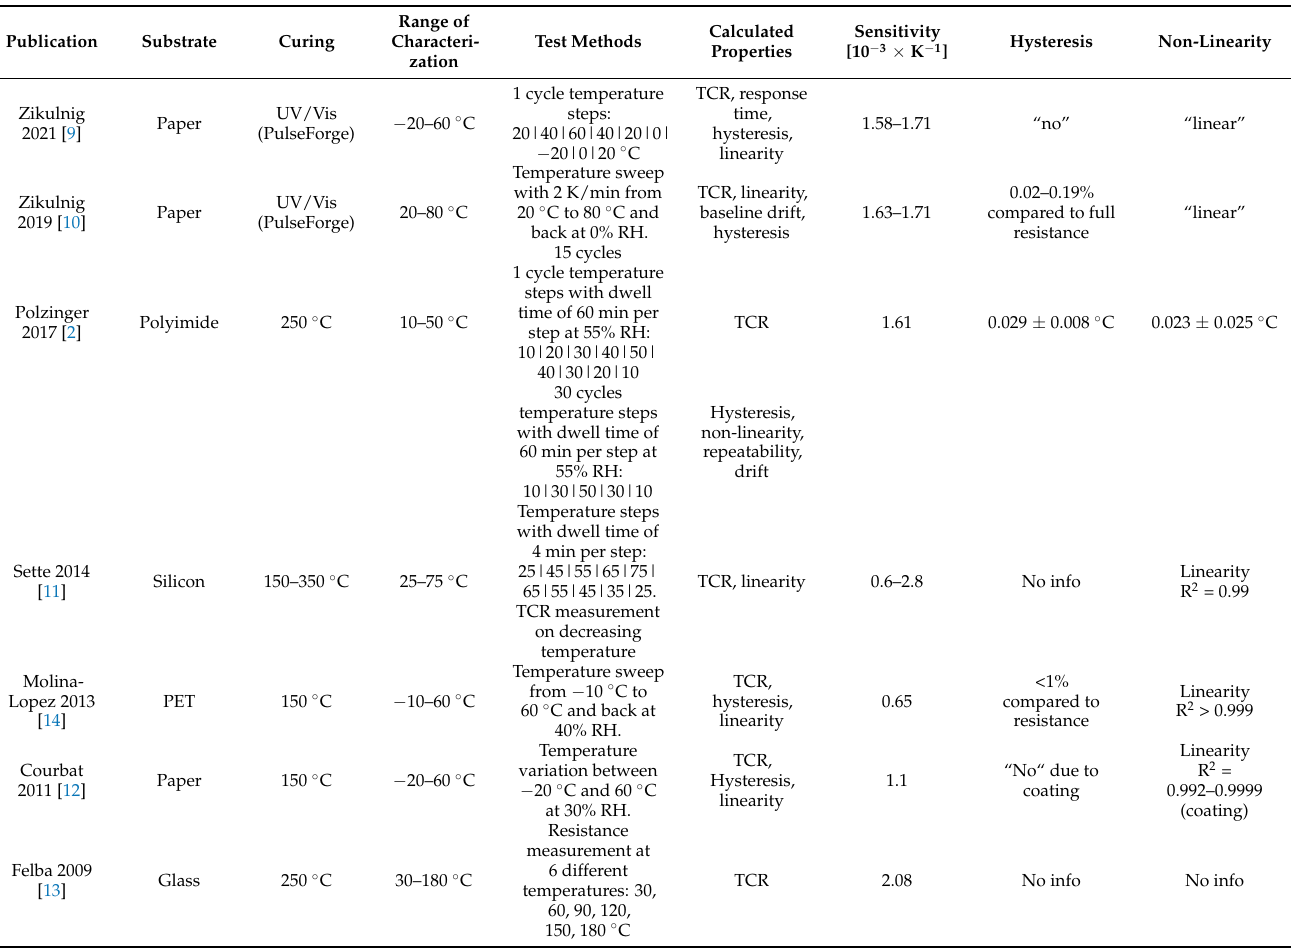
Table 1. Along with the TCR, the substrate, sintering method, range of characterization, test methods, as well as the hysteresis and non-linearity of inkjet-printed silver nanoparticle temperature sensors, are listed in Table 1. The ideal sensor should have a low hysteresis and a linear behavior. The values for these properties vary between different publications and are often stated with “no hysteresis” or “linear behavior”. Hence, a good comparison cannot be performed at this point. This is a reason for one goal of this publication, which is to provide values for these properties, according to the international standard IEC 61928-2. Table 1. Inkjet-printed resistive temperature sensors based on silver nanoparticles. The presented properties of the sensors were not tested according to a